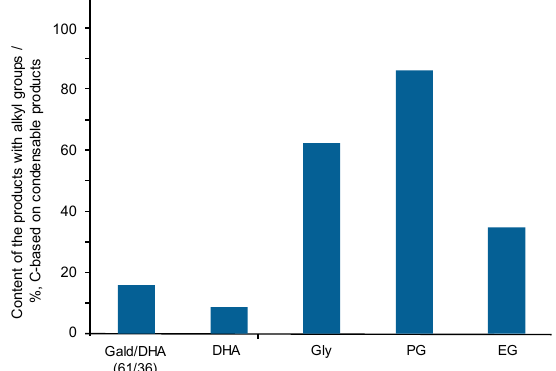
Figure 7. Contents (%, C-based) of the products with saturated and unsaturated alkyl groups in condensable products obtained from glyceraldehyde (Gald)/1,3-dihydroxyacetone (DHA) (61/36, mol/mol), DHA, glycerol (Gly), propylene glycol (PG), and ethylene glycol (EG) at 600 °C. The data of Gald/DHA, DHA and Gly are from literature [5].